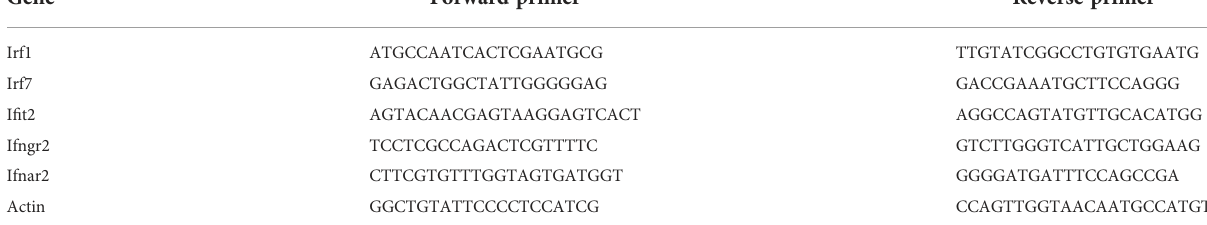
TABLE 1 Primers used for RT-qPCR in this